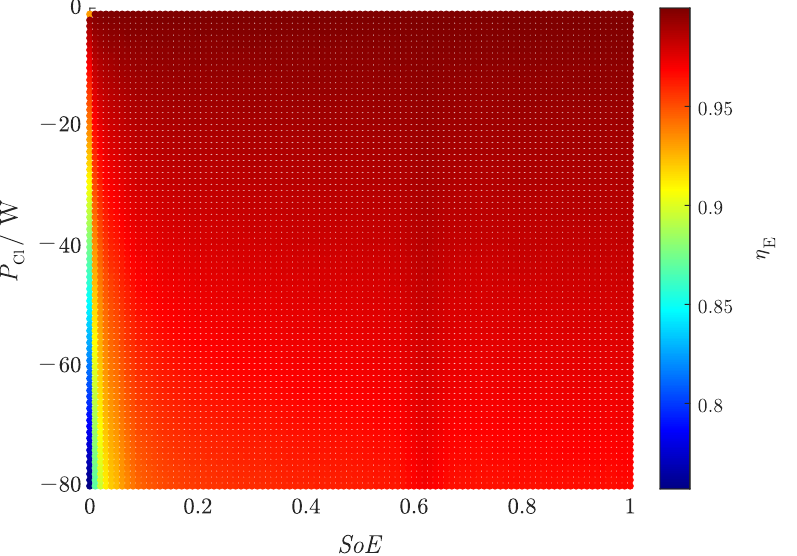
Figure A3. Efficiency map considering the discharge parameters with a discretization of the power of 1 W and a discretization of the SoE of